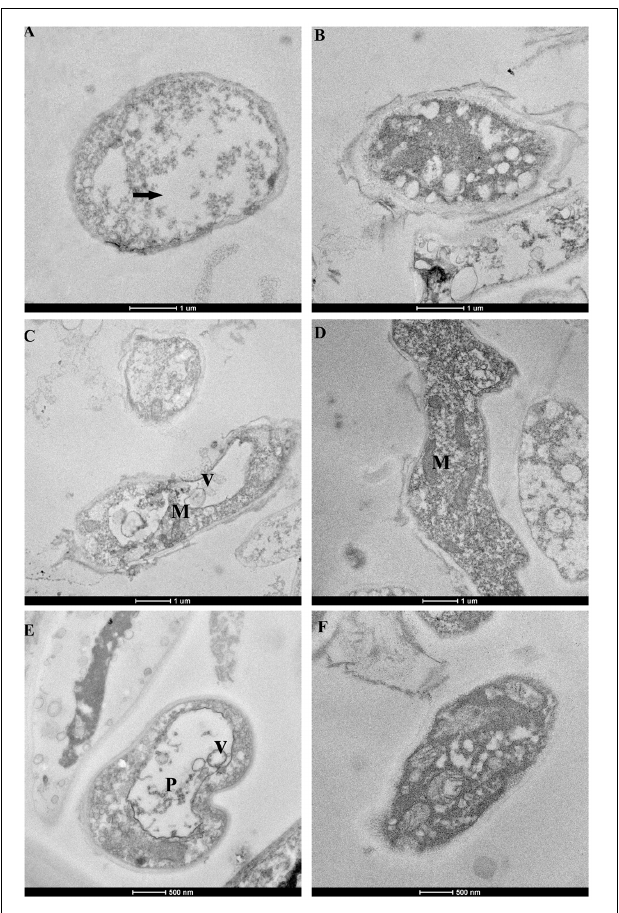
FIGURE 7 | Cytoplasmic characteristics of the dsRNA-containing hypovirulent strain BLH-1 (A,C,E) and the dsRNA-free virulent strain BLH-1-P1 (B,D,F) examined by TEM. (A) Hyphal cells of BLH-1 were degenerated, showing electron-sparse and unevenly distributed cytoplasm, indicated by arrow. (C) BLH-1 had significantly fewer mitochondria (indicated by M) with swollen shape, whereas BLH-1-P1 (D) contained numerous oval or oblong mitochondria. (E) Virus-like particles with sizes under 100 nm (indicated by P), and abundant vacuole-like membranous structures or small membranous vesicles (indicated by V) were observed in the hyphal cells of BLH-1. (F) Strain BLH-1-P1 shared dense and evenly distributed cytoplasm as that shown in (B) . Note: scale bars for pictures (A–D) were 1 µ m and for (E,F) were 500